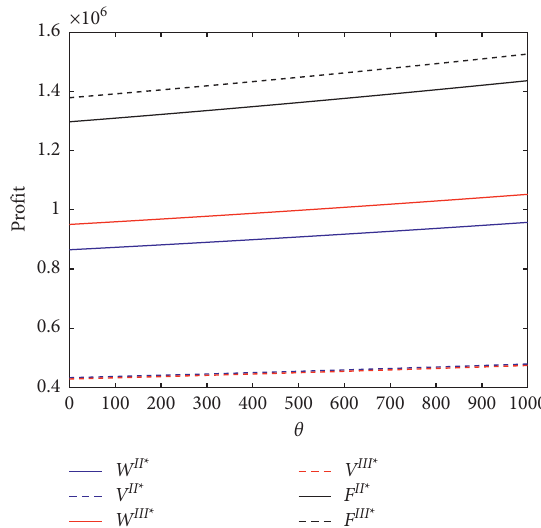
Figure 10: The effects of θ on